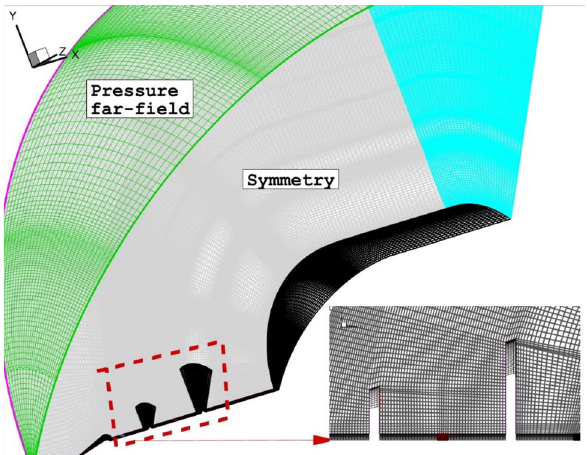
Figure 2. Grid production.